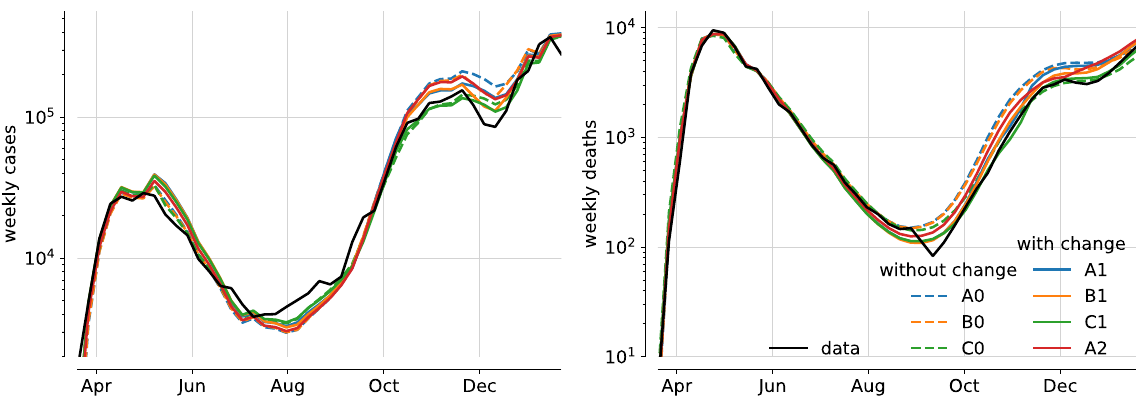
Fig 4. Mean trajectories of weekly cases and deaths for further model variants. Deterministic trajectories for the MAP parameters of the various model variants, along with data (black). Models without change in IFR are shown as dashed, models with change in IFR solid.